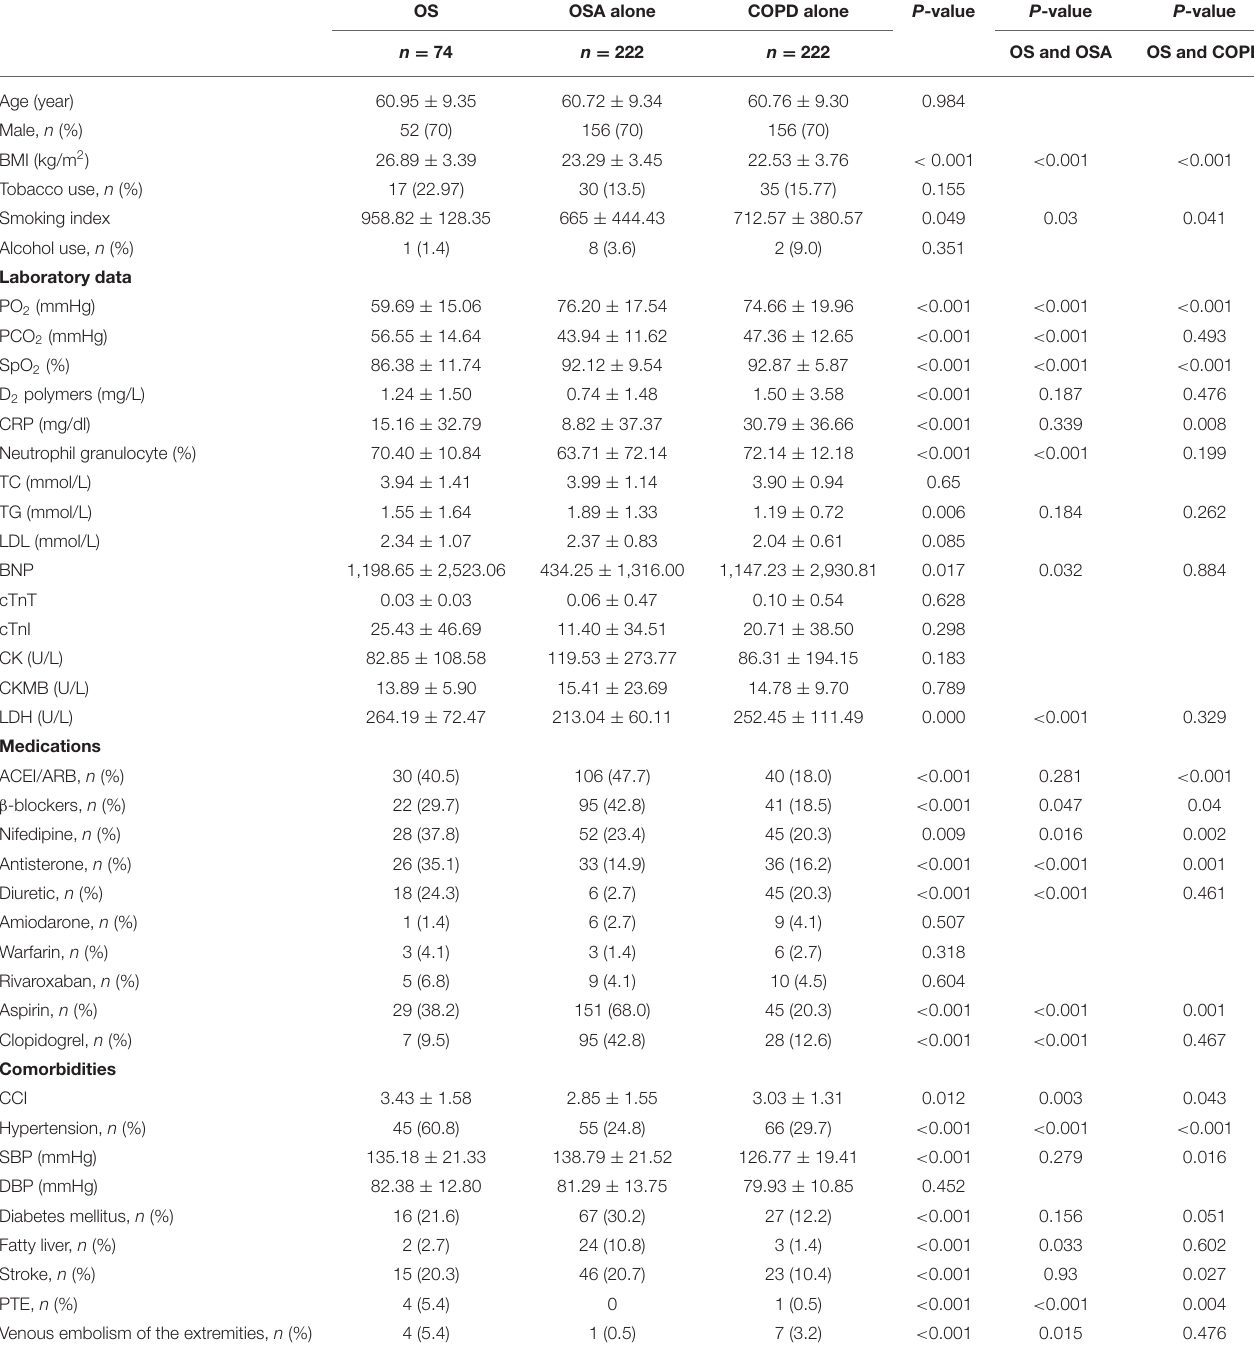
TABLE 1 | Characteristics of patients with OS, OSA, and COPD. OS OSA alone COPD alone P